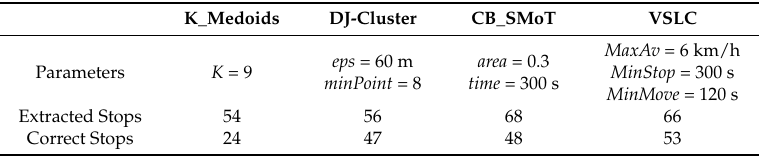
Table 3. Results of different stop extraction algorithms for Dataset